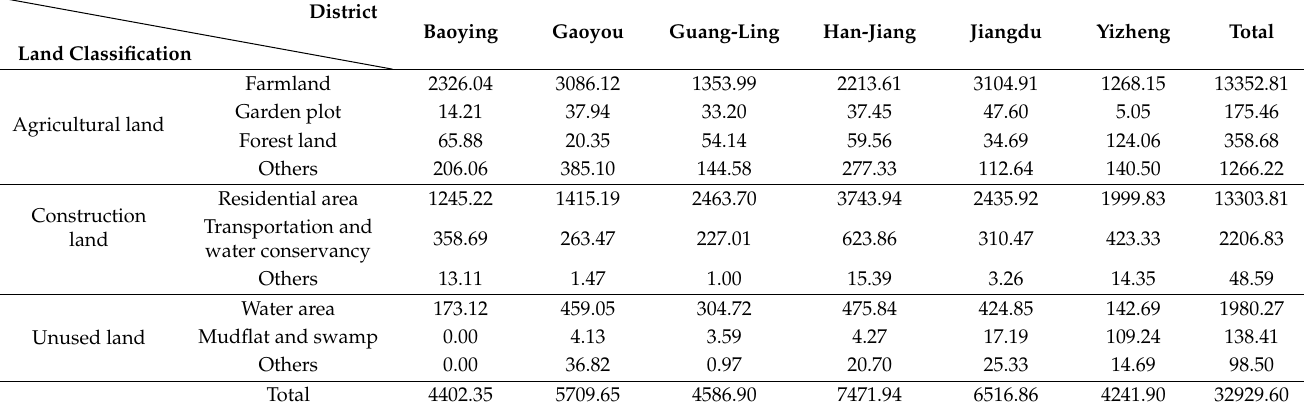
Table 2. Source analysis of urban land expansion in Yangzhou (unit: hm 2 ).